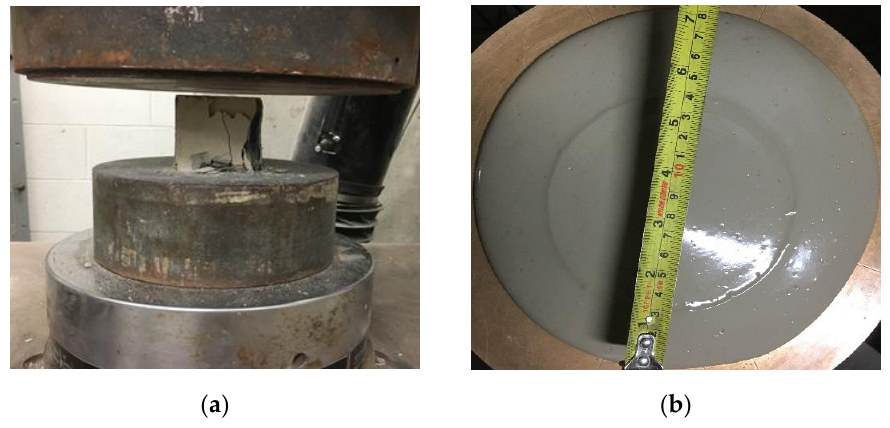
Figure 2. Test set-up for ( a ) compressive strength, ( b ) mini-slump